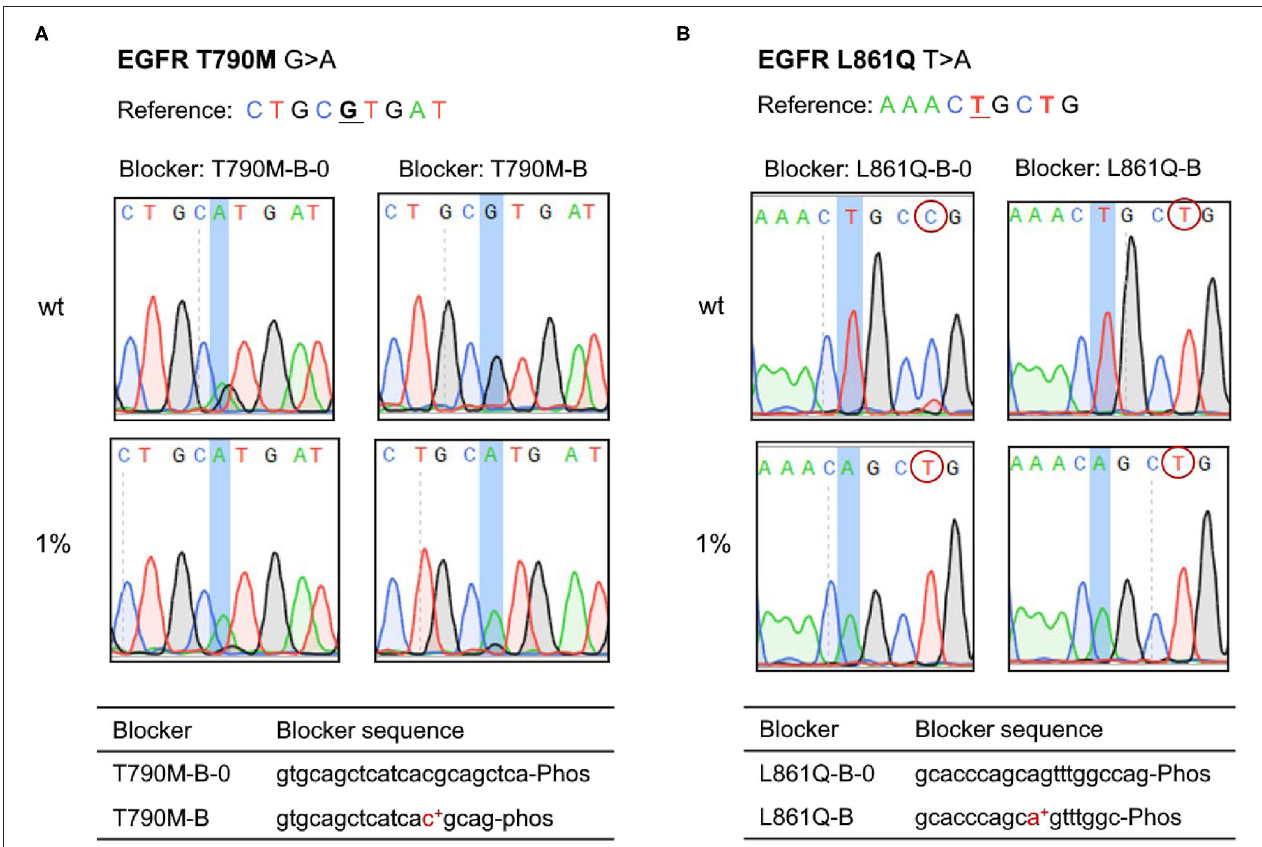
FIGURE 3 | Adjustment of PEAC system for specific mutations, of which the blocker probes are modified by shortening its sequence and adding LNA-modification at the mutation site. (A) EGFR T790M. For T790M-B-0 probe, an additional G base was introduced within the location of T790M, leading to false positives, whereas the improved T790M-B probe solved the problem. (B) EGFR L861Q. For EGFR L861Q mutation reaction, when enrichment is performed using L861Q-B-0 probe, a false positive mutation of T > C shows in wild-type sample, but it is eliminated when the improved L861Q-B probe is